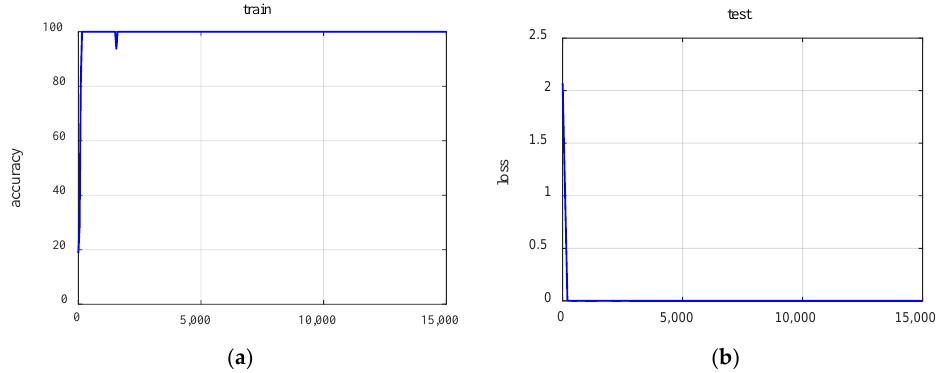
Figure 7. Accuracy and loss function curves for the test data. ( a ) Accuracy curve; ( b ) Loss function curves.